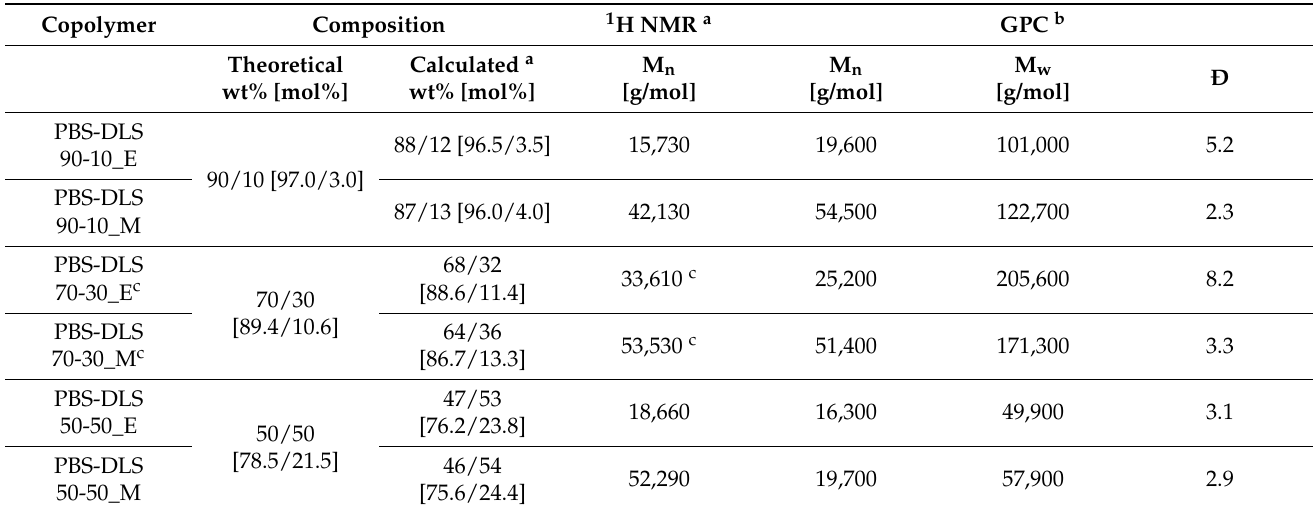
Table 2. Composition of PBS-DLS copolyesters determined from 1 H NMR and